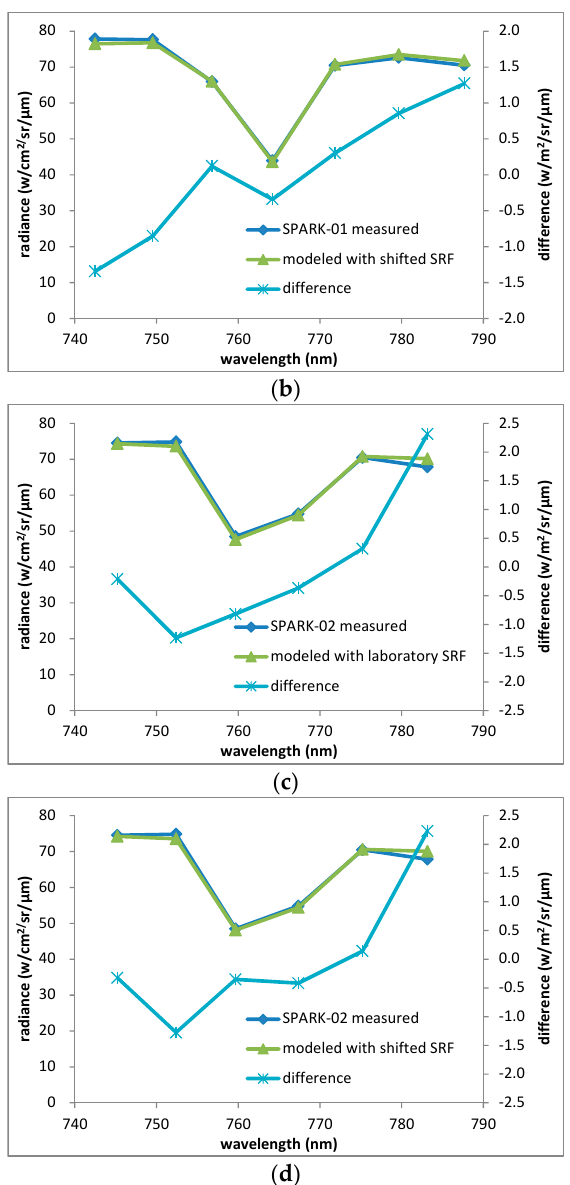
Figure 29. Spectral fit result and optimal spectral calibration result with an –0.1 nm shift at the desert in Dunhuang (Figure 5). ( a , c ) are for SPARK-01 before and after spectral shifting; and ( b , d ) are for SPARK-02 before and after spectral shifting.